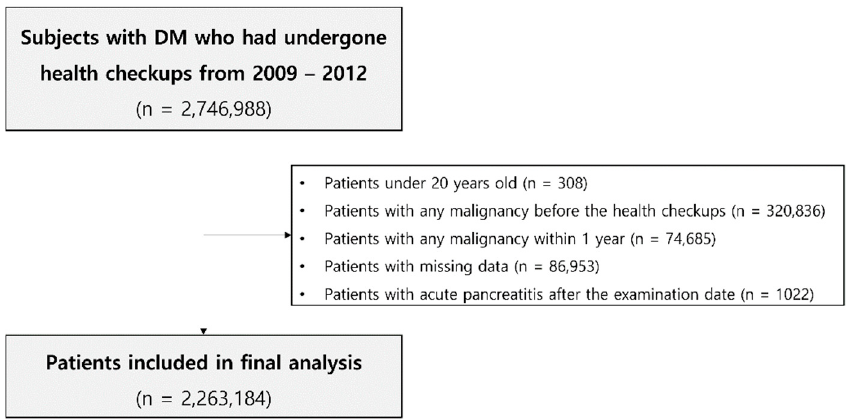
Figure 1. Flowchart showing the selection of subjects for this study.